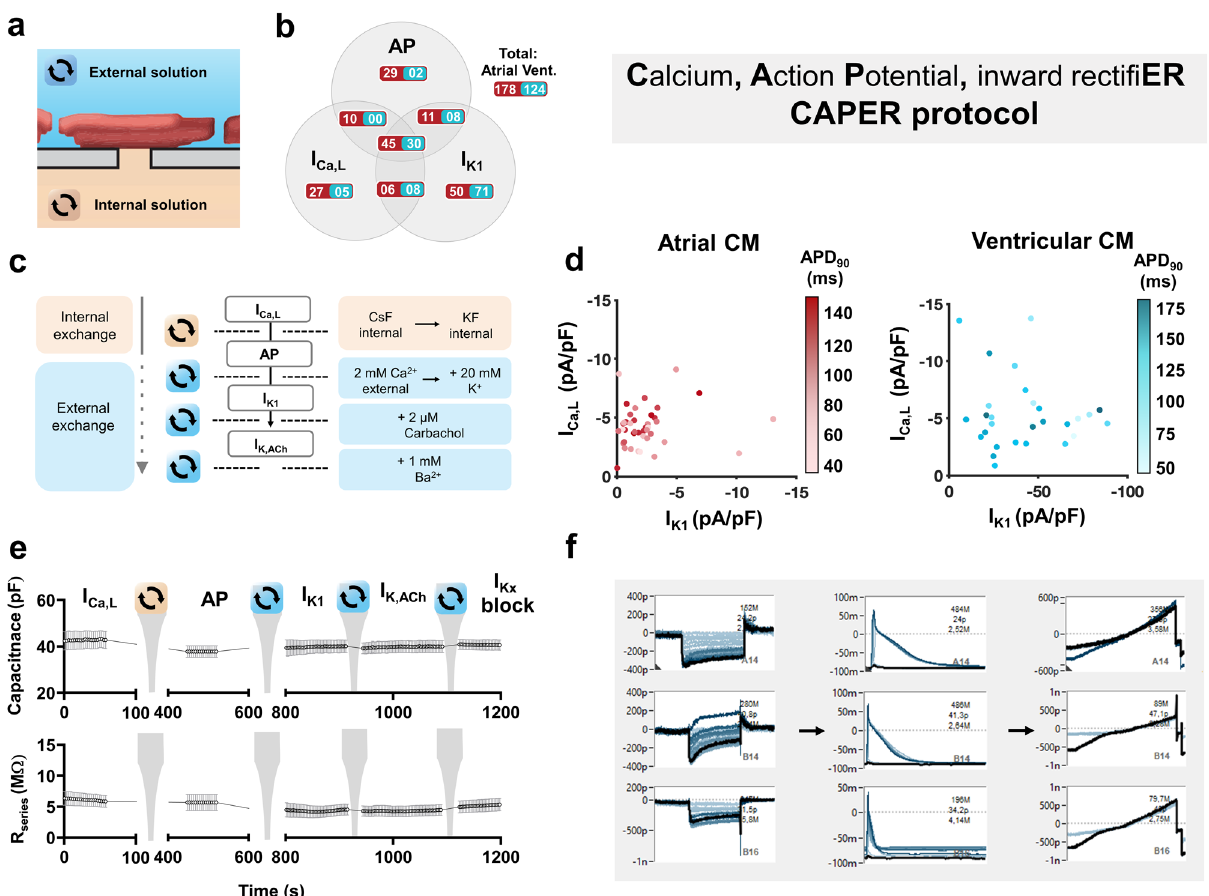
Fig. 6 Overview of the multi-current Calcium, Action Potential and inward recti fi ER (CAPER) protocol in native atrial and ventricular cardiomyoctes (CM) using automated patch-clamp. a Schematic of the cardiomyocyte-aperture interface with corresponding external (blue) and internal (orange) solutions. The substitution of which allows for multi-current acquisition from a single cell. b Shares of total CM numbers that showed successful measurements of any of the three parameters of interest (L-type calcium current ( I Ca,L ), action potential (AP) duration at 90% repolarization (APD 90 ) and basal inward recti fi er current ( I K1 ). The central total indicates the successful cohort of atrial and ventricular (Vent.) CMs in which all three parameters were successfully acquired. c A detailed overview of the CAPER protocol including sequential internal and/or external solution exchange during a single experimental run. The acetylcholine-activated inward recti fi er current ( I K,ACh ) is an optional addition to the protocol prior to the inward recti fi er block with BaCl 2 . d Three-dimensional visualization of I Ca,L , APD 90 , and I K1 relationships in atrial (left) and ventricular (right) CMs. APD 90 is expressed as a shadow spectrum where darker colors indicate longer AP duration. e Time course of membrane capacitance (upper) and series resistance ( R series ; lower) from a single plate ( n = 5 CMs) over a full CAPER run. f Direct acquisition software screenshots from a single plate (single animal) showing three complete electrophysiological measurements from single cells. Y -axis indicates the membrane current expressed as picoamperes (p) or nanoamperes (n) in the screenshots of I Ca,L (left) and I K1 (right) , or membrane voltage expressed as millivolts (m;